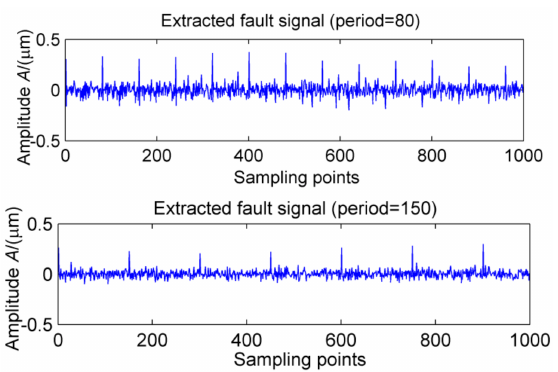
Figure 11. CPF + MOMEDA noise reduction